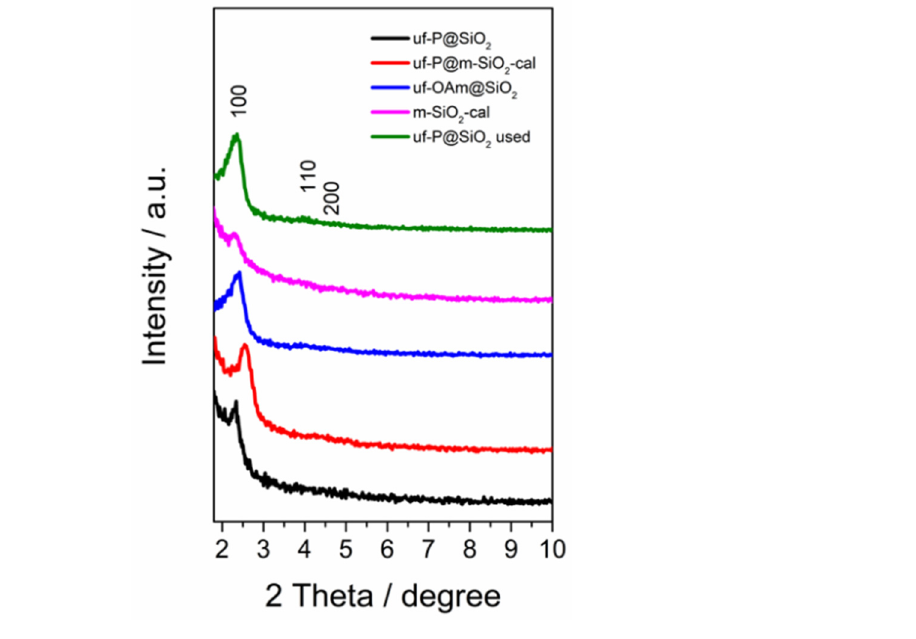
Figure 1. Glancing angle XRD patterns uf-P@m-SiO 2 (fresh and used), uf-P@m-SiO 2 -cal, uf-OAm@m- SiO 2 , and m-SiO 2 -cal samples.